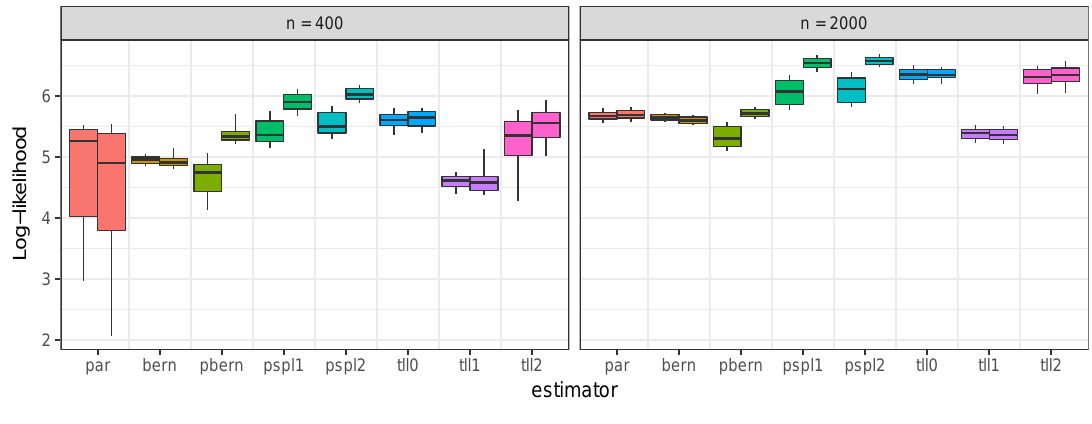
Figure 7: The box plots show the mean log-likelihood values attained by the different estimation methods. Each boxplot on the left hand side: structure selection based on Kendell’s τ and each boxplot on the right hand side: structure selection based on